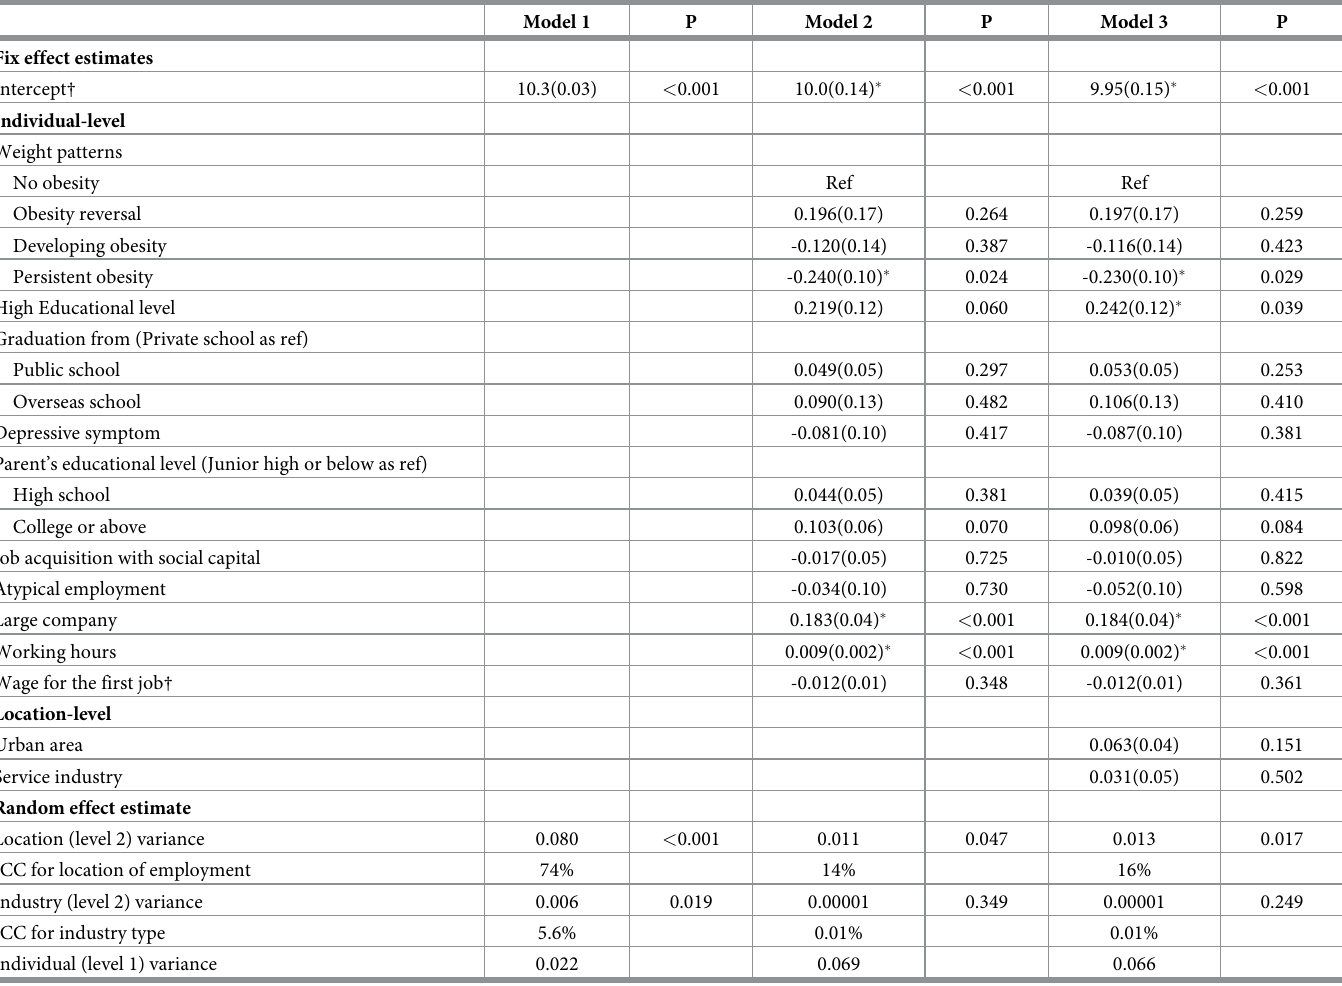
Table 3. Cross-classified multilevel model describing an association between predictors and monthly wage among women (N =